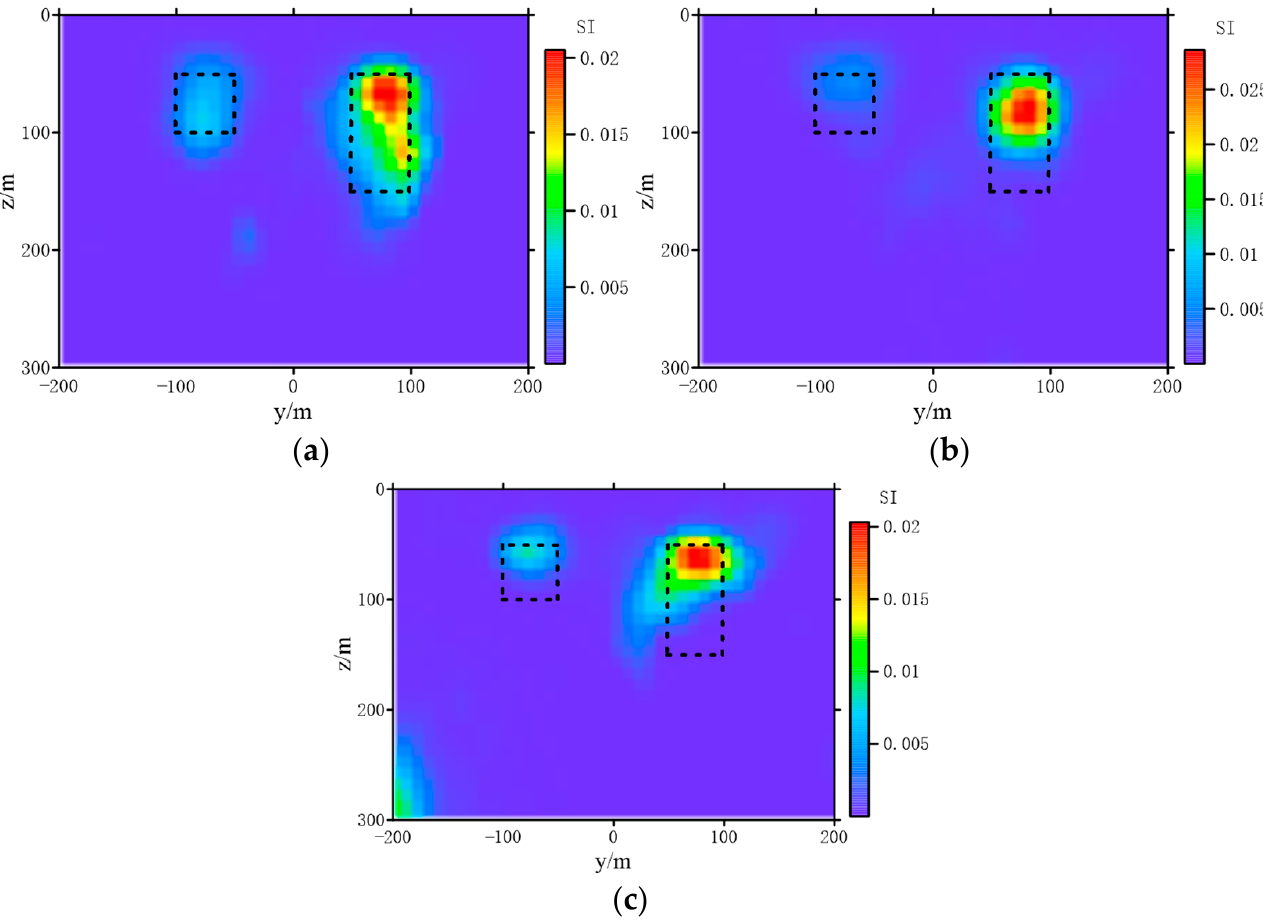
Figure 12. The inversion results with different noise level. ( a ) 1% noise, ( b ) 5% noise, ( c ) 10% noise.